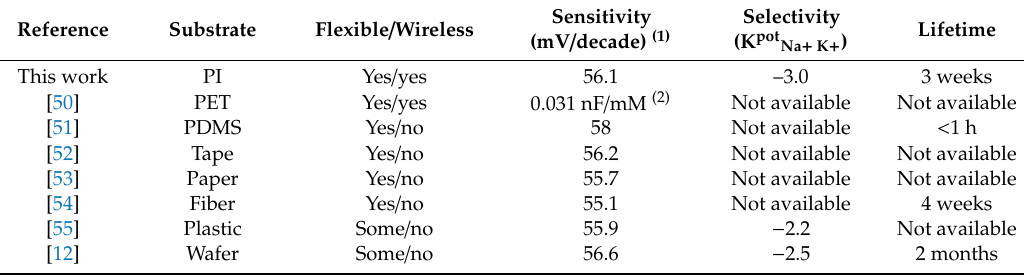
Figure S1: illustration of wireless ion-selective electrode circuit, Figure S2: voltage stability, Figure S3: saliva concentration measured from a commercial solid-state sensor, Figure S4: hydrophobicity and sensor capability of CB / Ecoflex transducer, Figure S5: drying shrinkage, Figure S6: PVC delamination from Ecoflex, Figure S7: long-term stability, Figure S8: repeatable measurement of sodium in saliva, Table S1: list of components used for circuit, and Table S2: performance comparison of carbon–polymer composite-based